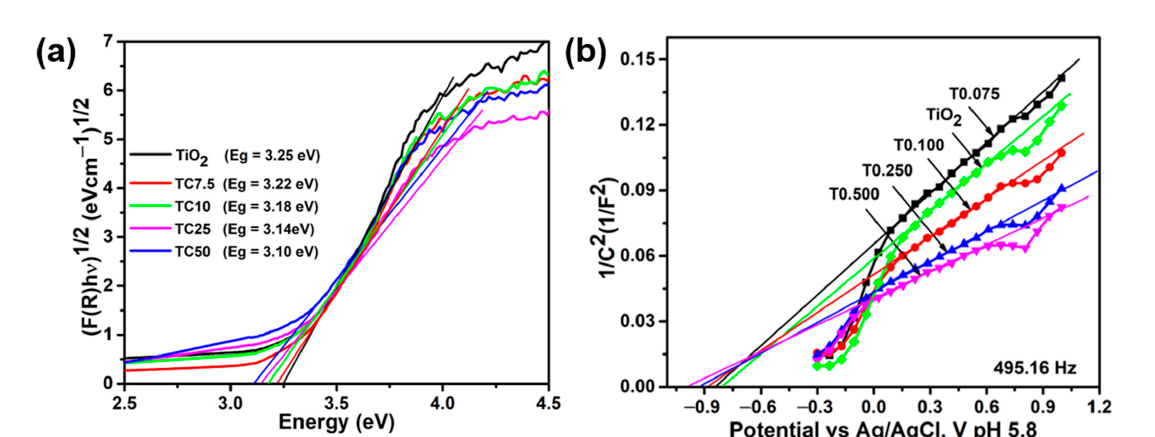
Figure 5. ( a ) Tauc plot and ( b ) Mott ˗ Schottky plot of pure TiO 2 P25 and synthesized materials.